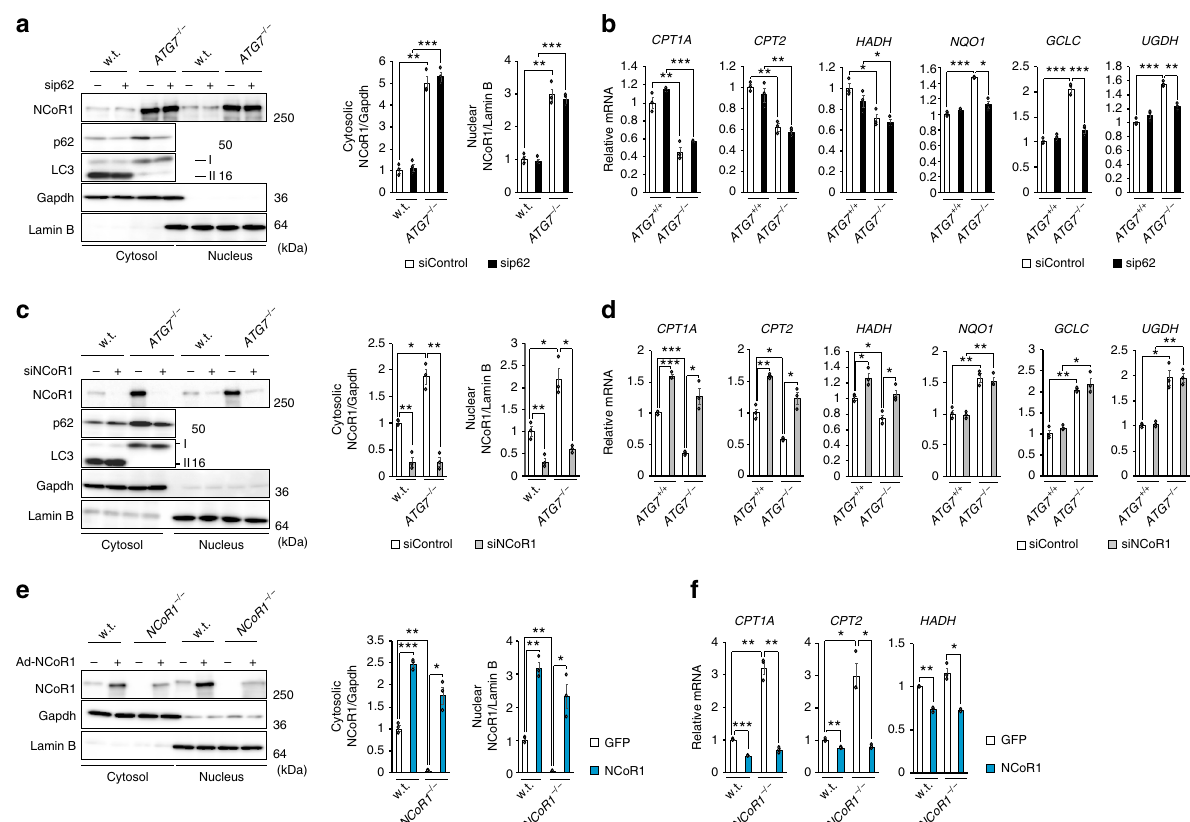
Fig. 4 NCoR1-dependent PPAR α -inactivation in autophagy-incompetent cells. a , c Immunoblot analysis. Parental and ATG7 -knockout HepG2 cells (#14) were treated with siRNA for p62 ( a ) and NCoR1 ( c ). Thereafter, both nuclear and cytoplasmic fractions were prepared and subjected to